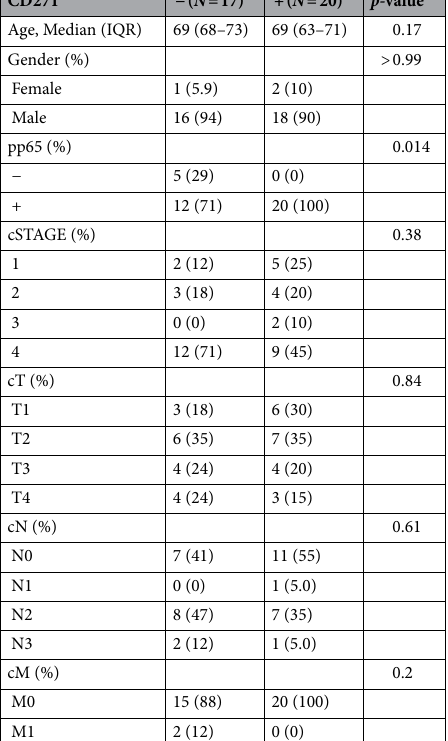
Table 2. Characteristics of patients with gastric cancer. 1 Wilcoxon rank sum exact test; Fisher’s exact